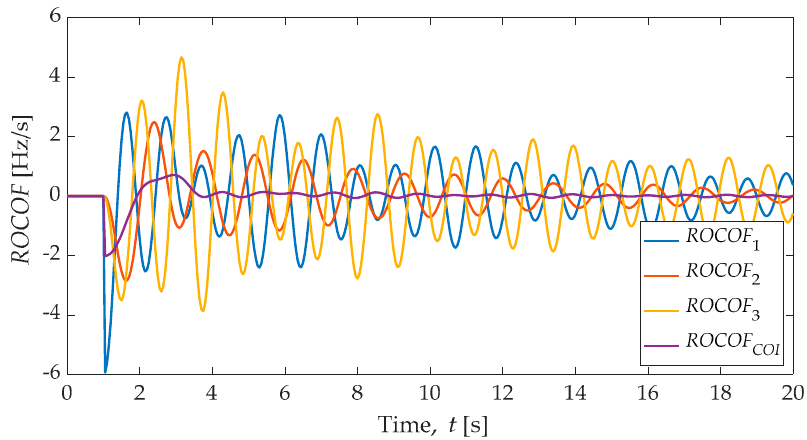
Figure 14. Rate-of-Change-of-Frequency ( ROFOF in Hertz/s) in a three-area power system